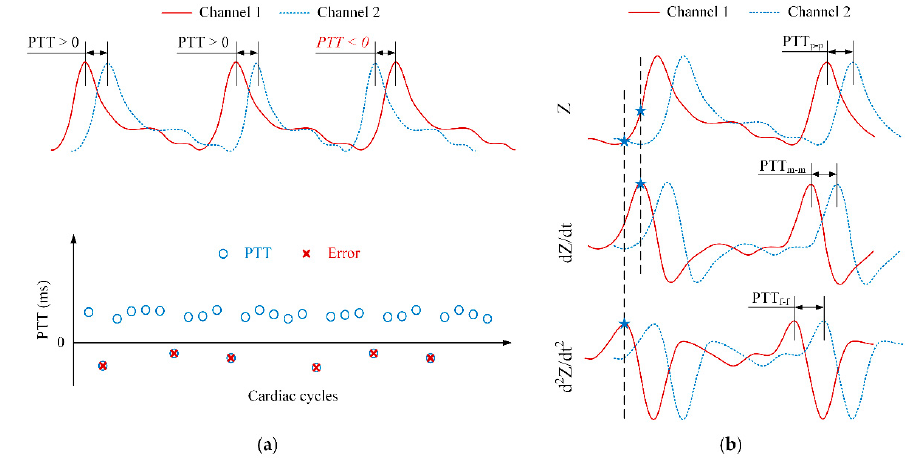
Figure 6. ( a ) Mistaken pulse transit time (PTT) values during the measurement process; ( b ) three types of PTT detections: peak-to-peak PTT (PTT p-p ), middle-to-middle PTT (PTT m-m ), and foot-to-foot PTT (PTT f-f ).